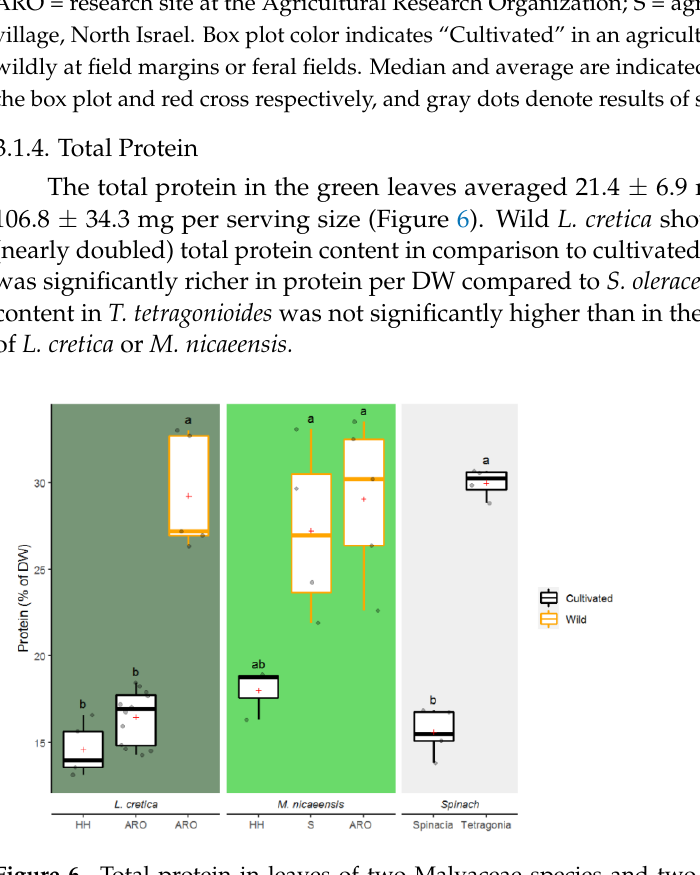
Figure 6. Total protein in leaves of two Malvaceae species and two spinach species. Different lowercase letters indicate significant differences between populations of green leaves ( p < 0.05). Species names and abbreviations of locations are given in the lower line. HH = Havat Hanoi, ARO = research site at the Agricultural Research Organization; S = agricultural area near Sandala village, North Israel. Box plot color indicates “Cultivated” in an agricultural field, or “Wild”, grown wildly at field margins or feral fields. Median and average are indicated as a horizontal line within the box plot and red cross respectively, and gray dots denote results of single